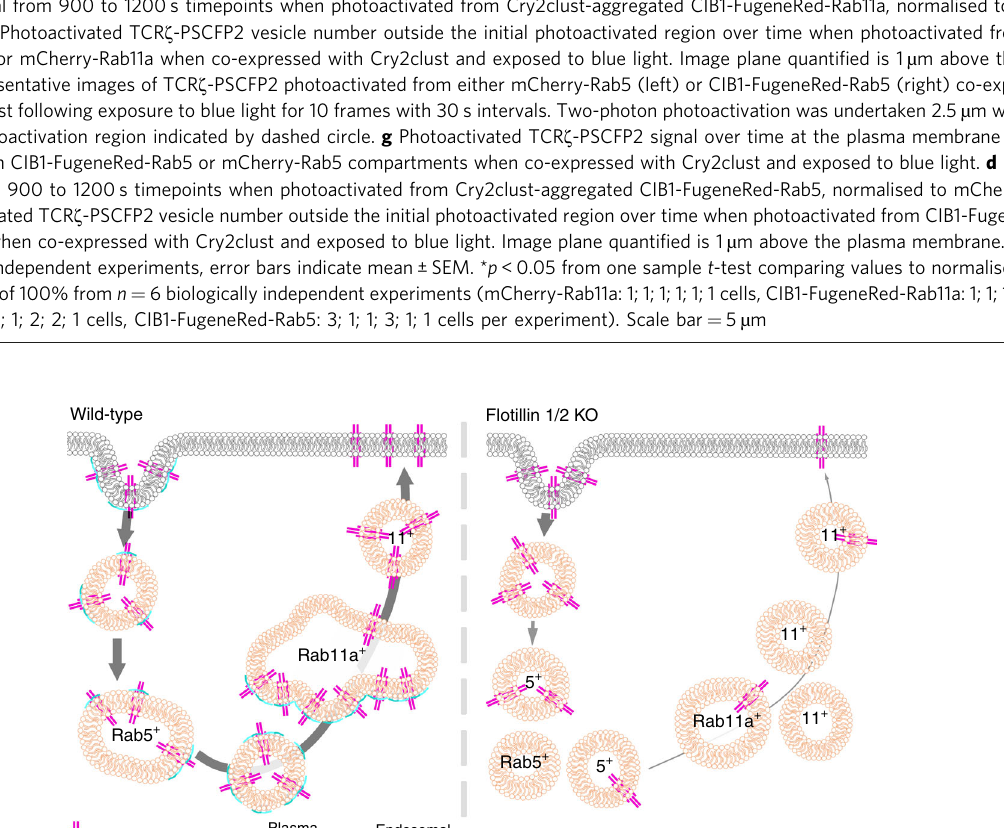
Fig. 6 Schematic of fl otillin regulation of receptor sorting and recycling. Following endocytosis in WT cells (left), TCR ζ is ef fi ciently sorted from fl otillin- positive endosomes into Rab5-positive endosomes via rapid interaction, then transferred into Rab11a-positive endosomes via fl otillin-positive endosomes and recycled to the plasma membrane within Rab11a-positive vesicles in an fl otillin-independent manner. In fl otillin 1 and 2 knockout cells (right) TCR ζ endocytosis is unaffected, but TCR ζ entry into, and the spatial organisation of, Rab5-positive and Rab11a-positive endosomes is perturbed, leading to reduced TCR ζ entry into Rab5-positive endosomes and large reduction of TCR ζ transfer from Rab5 into Rab11a-positive endosome, resulting in impaired TCR ζ recycling to the plasma divided fi rst by the PAmCherry mask, then the Rab mask to calculate the total endosomal PA-mCherry intensity present in Rab compartments. Statistical analysis . All statistical analysis excepting time of divergence analysis were performed using GraphPad software (Graphpad Prism, RRID:SCR_002798). Statis- tical signi fi cance between datasets was determined by performing two-tailed, unpaired non-parametric Students T -tests or one sample T -tests, where stipulated. Graphs show mean values, and error bars represent the SEM. In statistical analysis, p >0.05 is indicated as not signi fi cant (n.s.), whereas statistically signi fi cant values are indicated by asterisks as follows: * p ≤ 0.05, ** p <0.01, *** p <0.001. Time of divergence analysis was performed using a custom MatLab script. To determine the time-point of divergence, pooled fl uorescence intensity distributions of WT and FlotKO#1 were compared by means of the non-parametric Wilcoxon rank-sum test at each time point. Brie fl y, the null hypothesis that WT and FlotKO#1 data sets are from continuous distributions with equal medians is tested against the alternative hypothesis they are not. For each time-point a p -value is calculated, with the time point of divergence de fi ned as the fi rst time-point after which all subsequent p -values are equal to or smaller than the considered signi fi cance level. * p ≤ 0.05, ** p < 0.01.